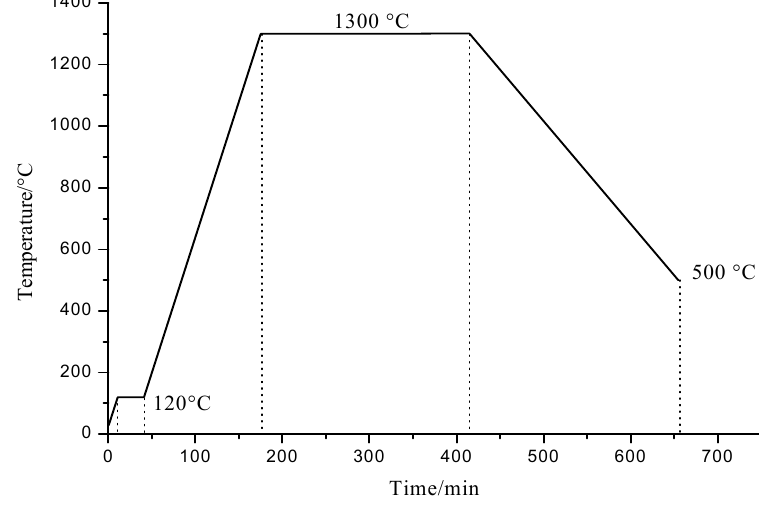
Figure 1. Temperature control curve of heat treatment.